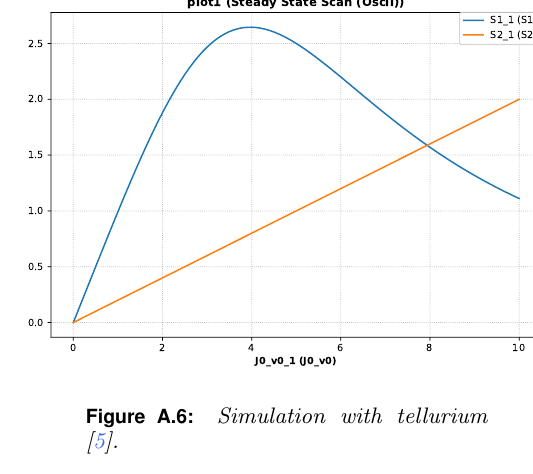
Figure A.6: Simulation with tellurium